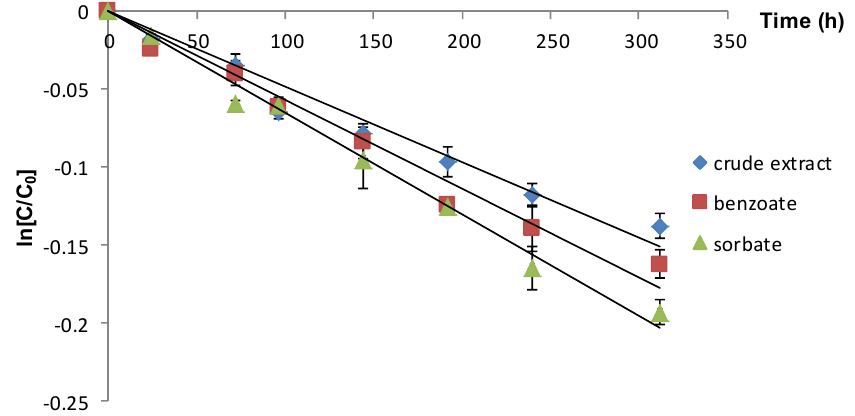
Figure 1. Influence of different food preservatives on the anthocyanin stability during storage at 2 °C (vertical lines represent SD, n =